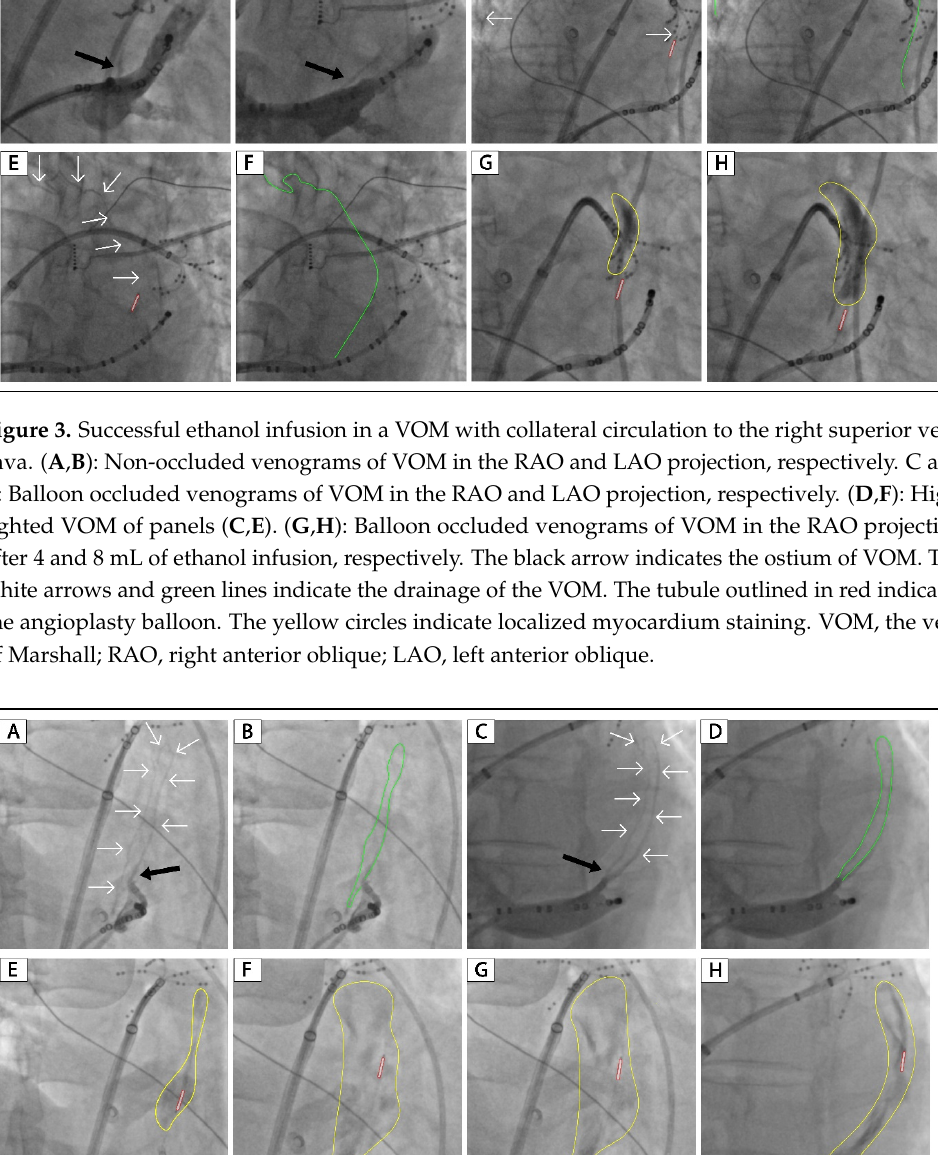
Figure 4. Successful ethanol infusion in a VOM with collateral circulation to the great cardiac vein. ( A , C ): Non ‐ occluded venograms of VOM in the RAO and LAO projection, respectively. ( B , D ): High ‐ lighted VOMs of panels ( A , C ), respectively. ( E – G ): Balloon occluded venograms of VOM in the RAO projection after 2, 4, and 8 mL of ethanol infusion, respectively. ( H ): Balloon occluded venograms of VOM in the LAO projection after 8 mL of ethanol infusion. The black arrow indicates the ostium of VOM. The white arrows and green lines indicate the drainage of the VOM. The tubule outlined in red indicates the angioplasty balloon. The yellow circles indicate localized myocardium staining. VOM, the vein of Marshall; RAO, right anterior oblique; LAO, left anterior oblique.